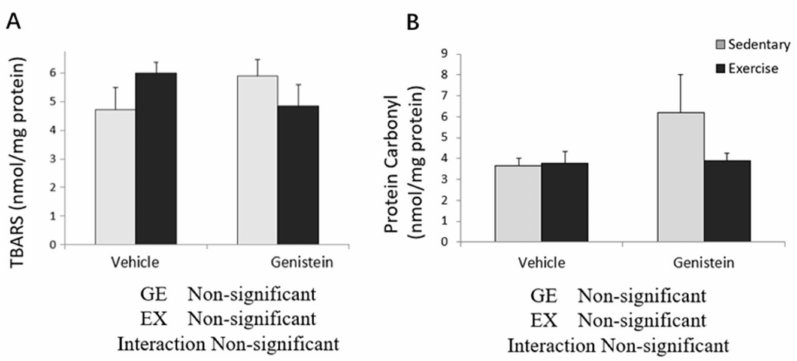
Figure 3. ( A ) Skeletal muscle TBARS (Con, n = 6; GE, n = 7; Ex, n = 8; GE + EX, n = 6); ( B ) protein carbonyl (Con, n = 5; GE, n = 7; Ex, n = 8; GE + EX, n = 6), vehicle: non-supplemented groups (only administrated with 0.5% CMC-Na solution); GE: GE-supplemented groups. Values are means ± SE.